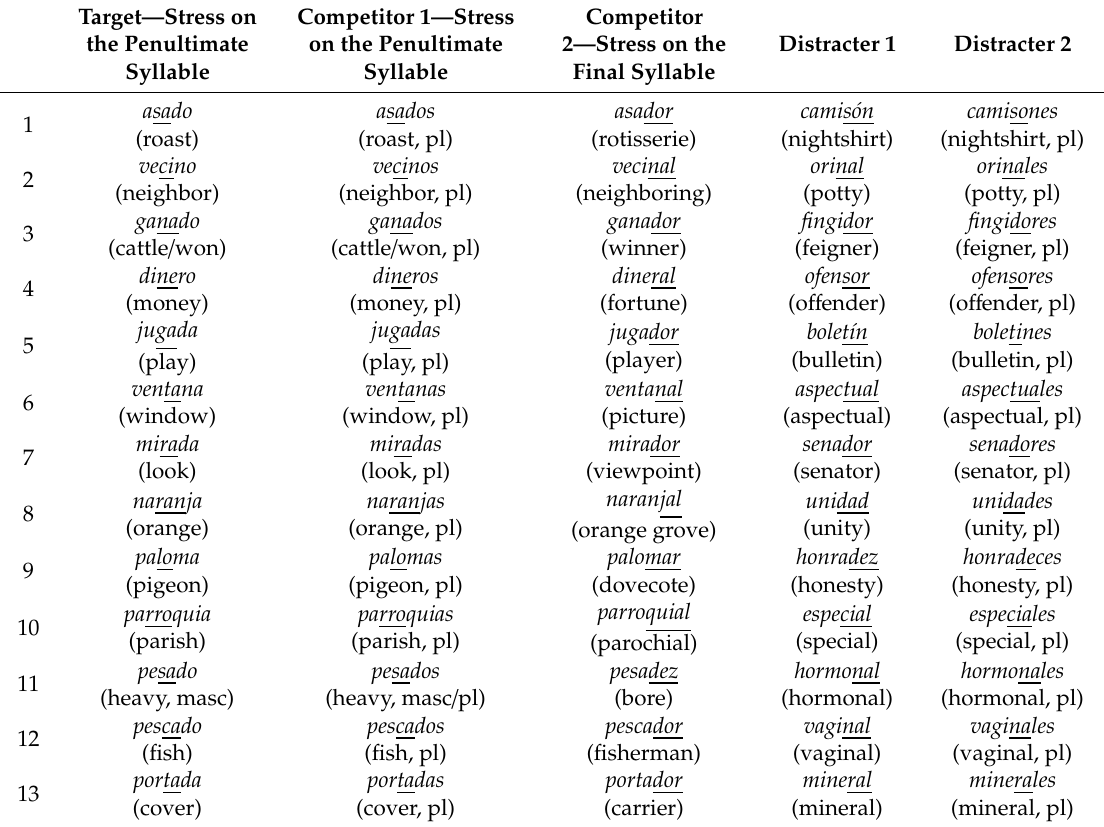
Table A1. List of experimental and distracter stimuli in the non-cognate condition. Remember that the presence of the competitors was randomized in two lists. While in List 1 a participant saw the pair asado-asados , in List 2, participants would see asado-asador